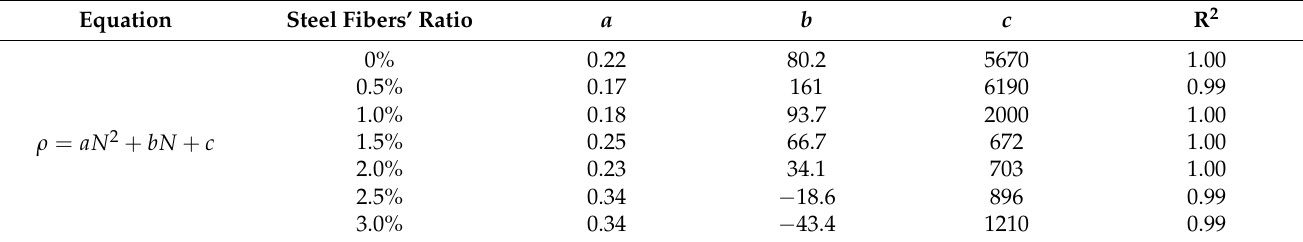
Table 6. The fitting results of the relationship between ρ and the N .